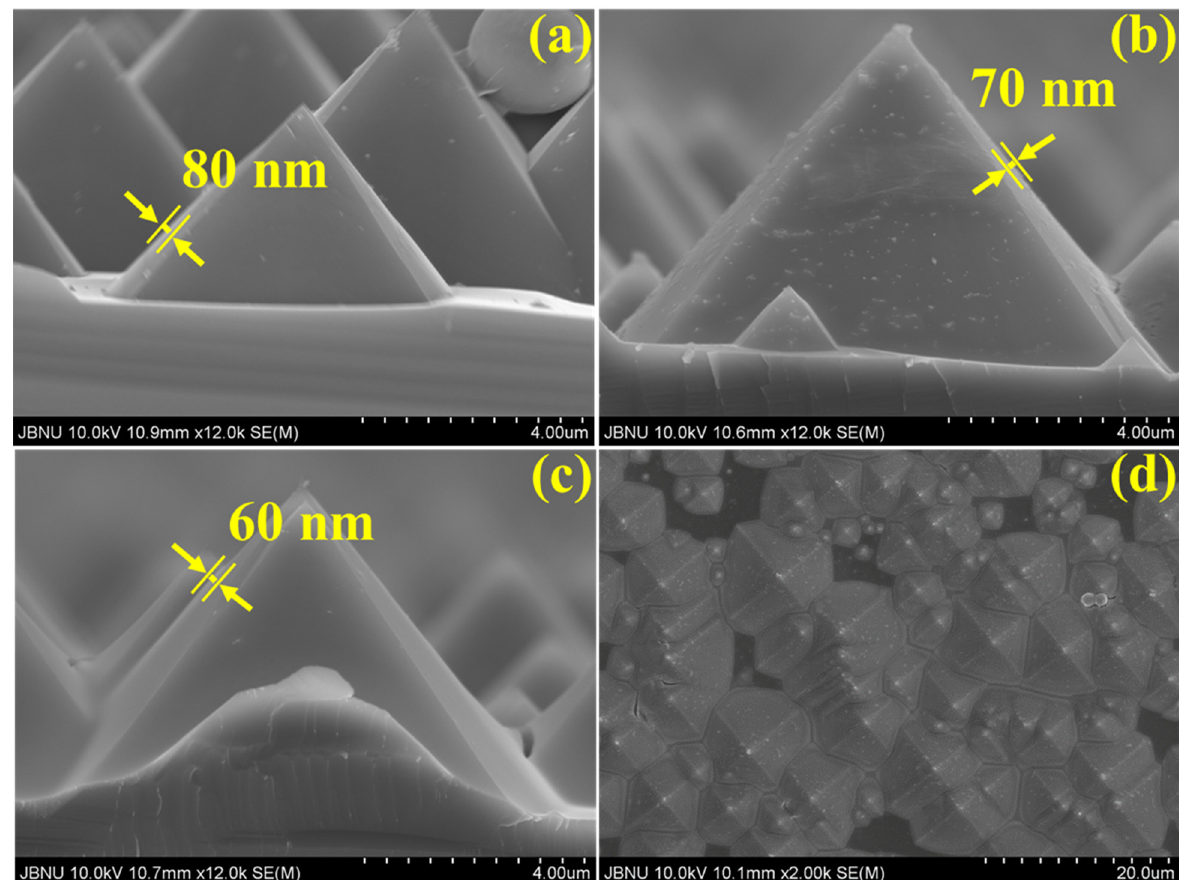
Figure 3. FE-SEM images of HfO 2 ARC layer-deposited at rpm ( a ) 1000, ( b ) 2000, ( c ) 3000, and ( d ) 2000 on the c-Si substrate. ( d ) 2000 on the c-Si